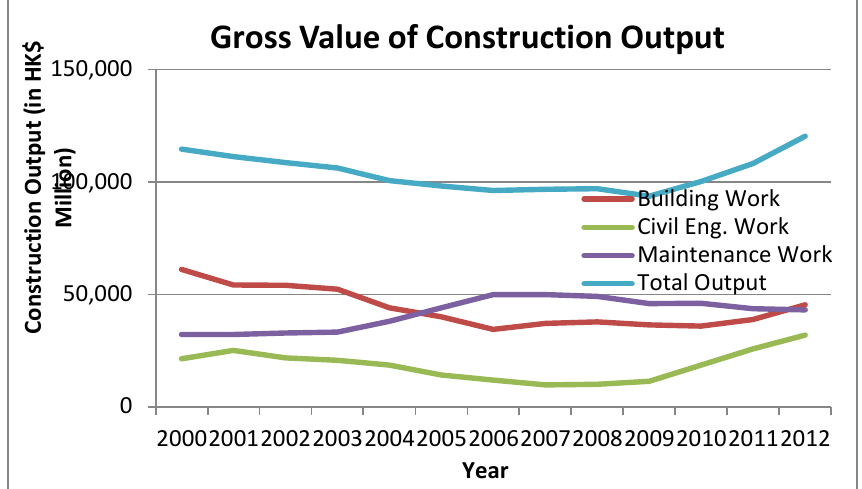
Figure 2 Annual Gross Value of Construction Output at Constant (2000) Market Prices